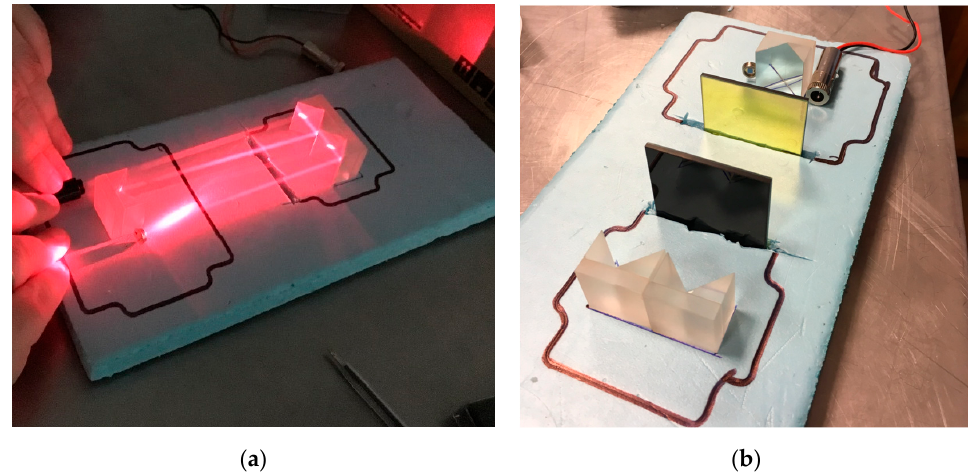
Figure 4. A prototype of the optical densitometer for reduced-scale fire research before the final assembly: ( a ) Illustration of the idea of the operation of the densitometer (with a 633 nm laser); ( b ) pre-assembly fitting of important optical components of the device.